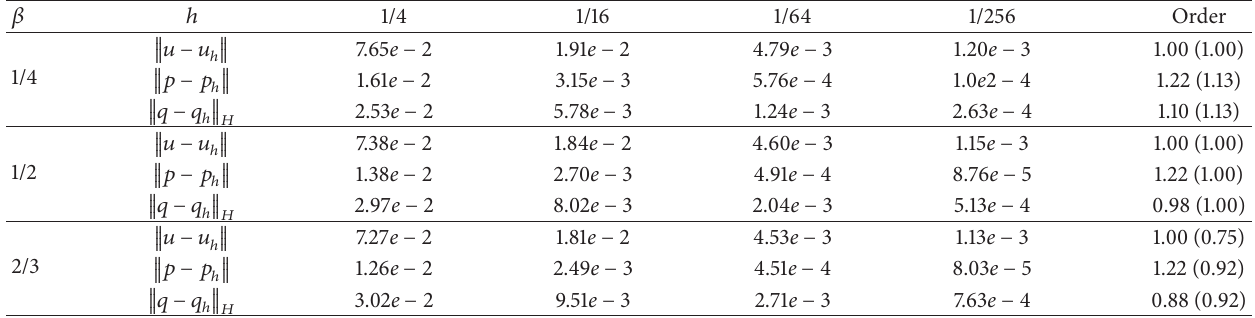
Table 7: Numerical result of Example 4 on a uniform mesh of size ℎ for 𝑘 = 1 .